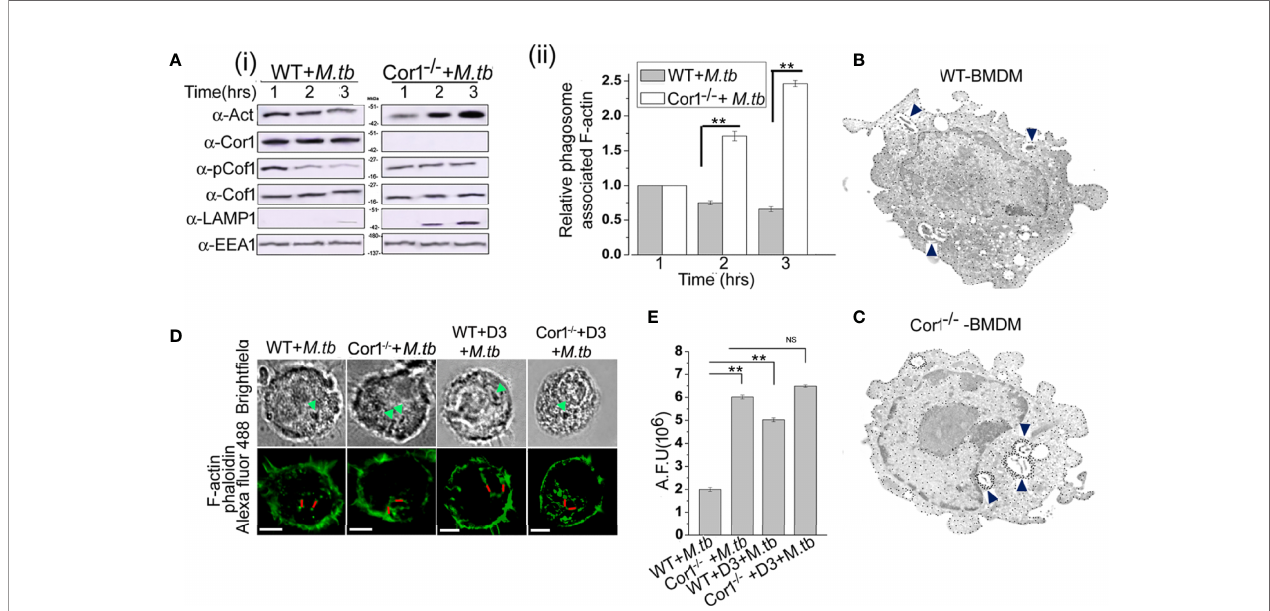
FIGURE 5 | (A) (i) Immunoblot of F-actin, Cor1, pCof1, LAMP1, and EEA1 and (ii) densiometric analysis of F-actin, all crosslinked to isolated phagosomes from M. tb infected [ A (i) left panel] wild type and [ A (i) right panel] Cor1 -/- BMDM. Infection was carried out at MOI 1:20 for indicated time points. (B, C) Immunogold transmission electron microscopy for F-actin was carried out in M. tb infected (B) WT and (C) Cor1 -/- BMDM. Infection was carried out at MOI 1:20 for 90 min. Blue arrows indicate M. tb -containing phagosomes in both cell types with dense dots corresponding to F-actin around mycobacteria-containing phagosomes in Cor1 -/- BMDM. (D) Immuno fl uorescence analysis of F-actin (phalloidin-Alexa Fluor 488-green) around mycobacteria-containing phagosomes in M. tb infected WT (left panel) and Cor1 -/- (right panel) BMDM. Green arrows in the bright fi eld indicate mycobacteria-containing phagosomes, while the red line corresponds to the arbitrary fl uorescence units (AFU) corresponding to polymerized F-actin around phagosomes (scale: 10 m m). (E) AFU values corresponding to the number of 50 cells were averaged and plotted. Representation for wild type or Cor1 -/- BMDM either untreated or pretreated with D3 and after that infected with M. tb at MOI of 1:20 for 90 min was carried out. Data represents mean ± SEM; ** p < 0.01, NS, non-signi fi